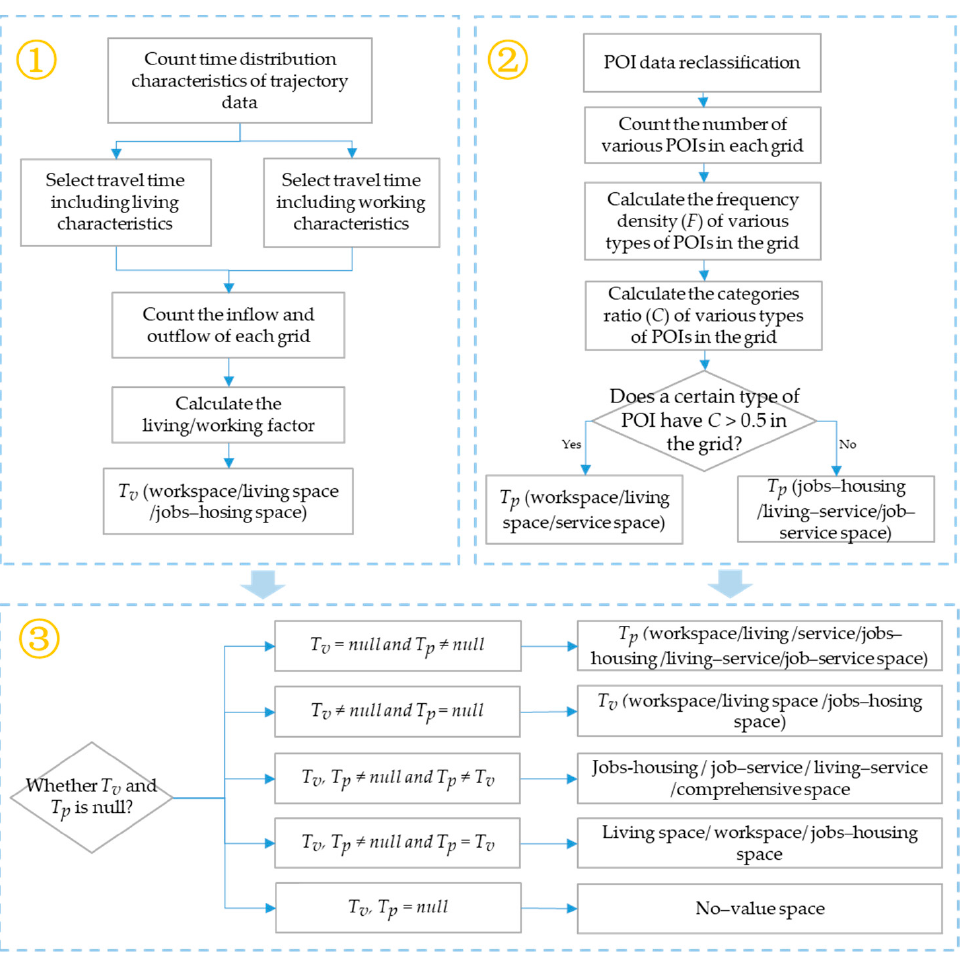
Figure 1. Flowchart of the proposed method. 𝐹 represents the frequency density. 𝐶 represents the category ratio. T v represents the recognition results from step1 . T p represents the recognition results from step 2.